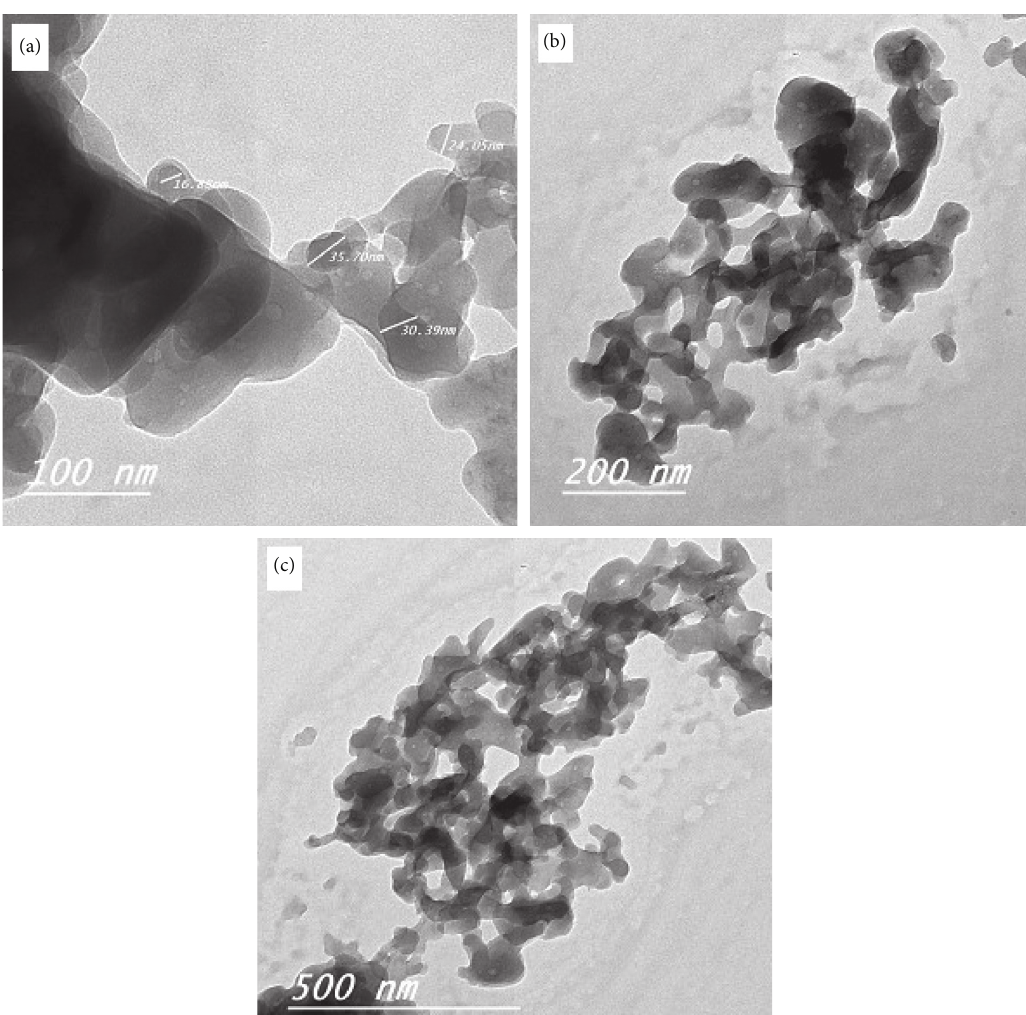
Figure 8: TEM pictures of (a) Ga(III), (b) Ge(IV), and (c) Hf(IV) folate complexes. Table 6: Antimicrobial assessments of Ga(III), Ge(IV), and Hf(IV) folate complexes.